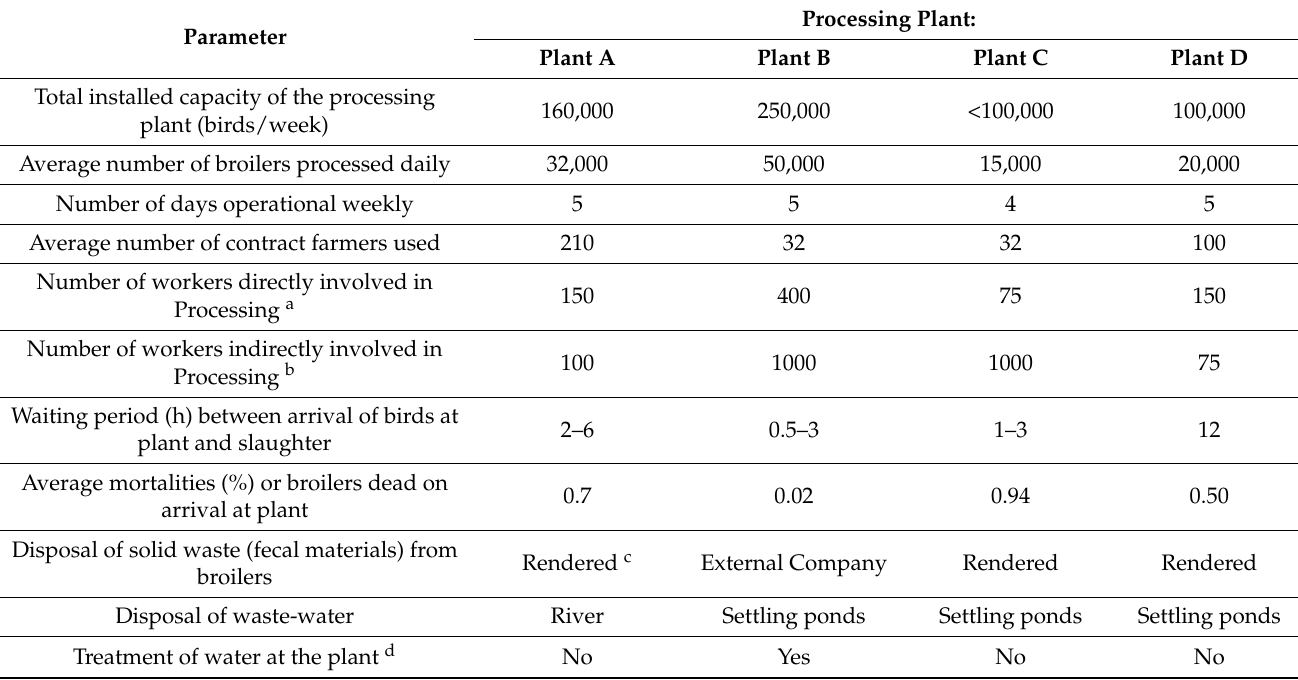
Table 1. Management and production data from four broiler processing plants in